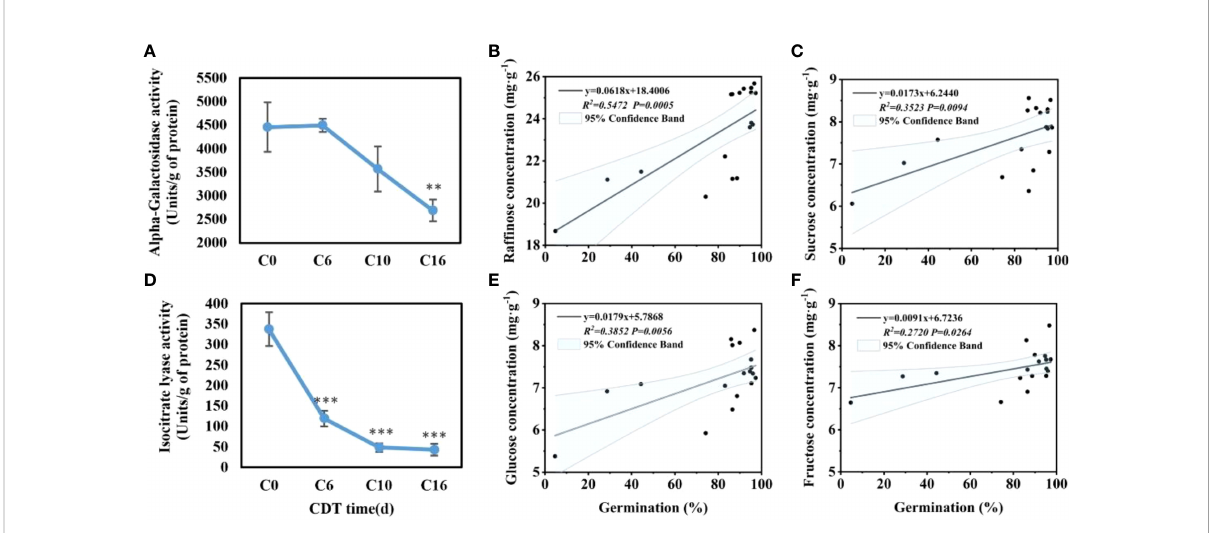
FIGURE 4 Effects of aging days on the activity of alpha-galactosidase (A) and isocitrate lyase (D) , and the correlation between germination and concentration of raf fi nose (B) , glucose (E) , sucrose (C) , and fructose (F) . Data are mean ± SE. * indicates a signi fi cant difference at P < 0.05, ** at P < 0.01, *** at P <